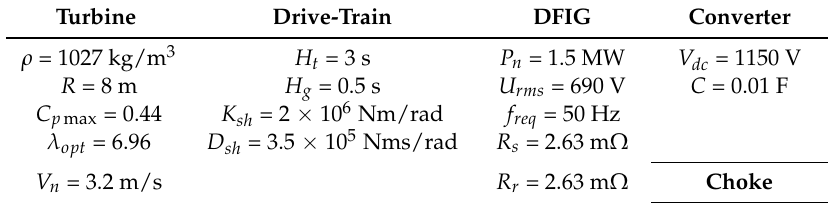
Table 4. Tidal Stream Generator (TSG) system parameters.